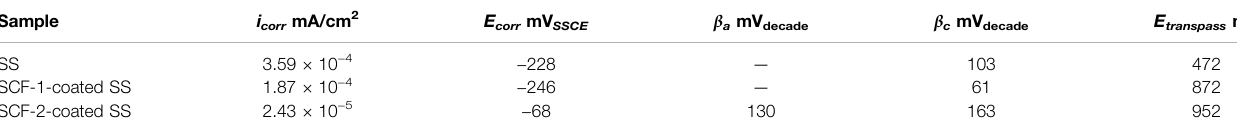
TABLE 2 | Polarization parameters obtained by the intercept method. Sample